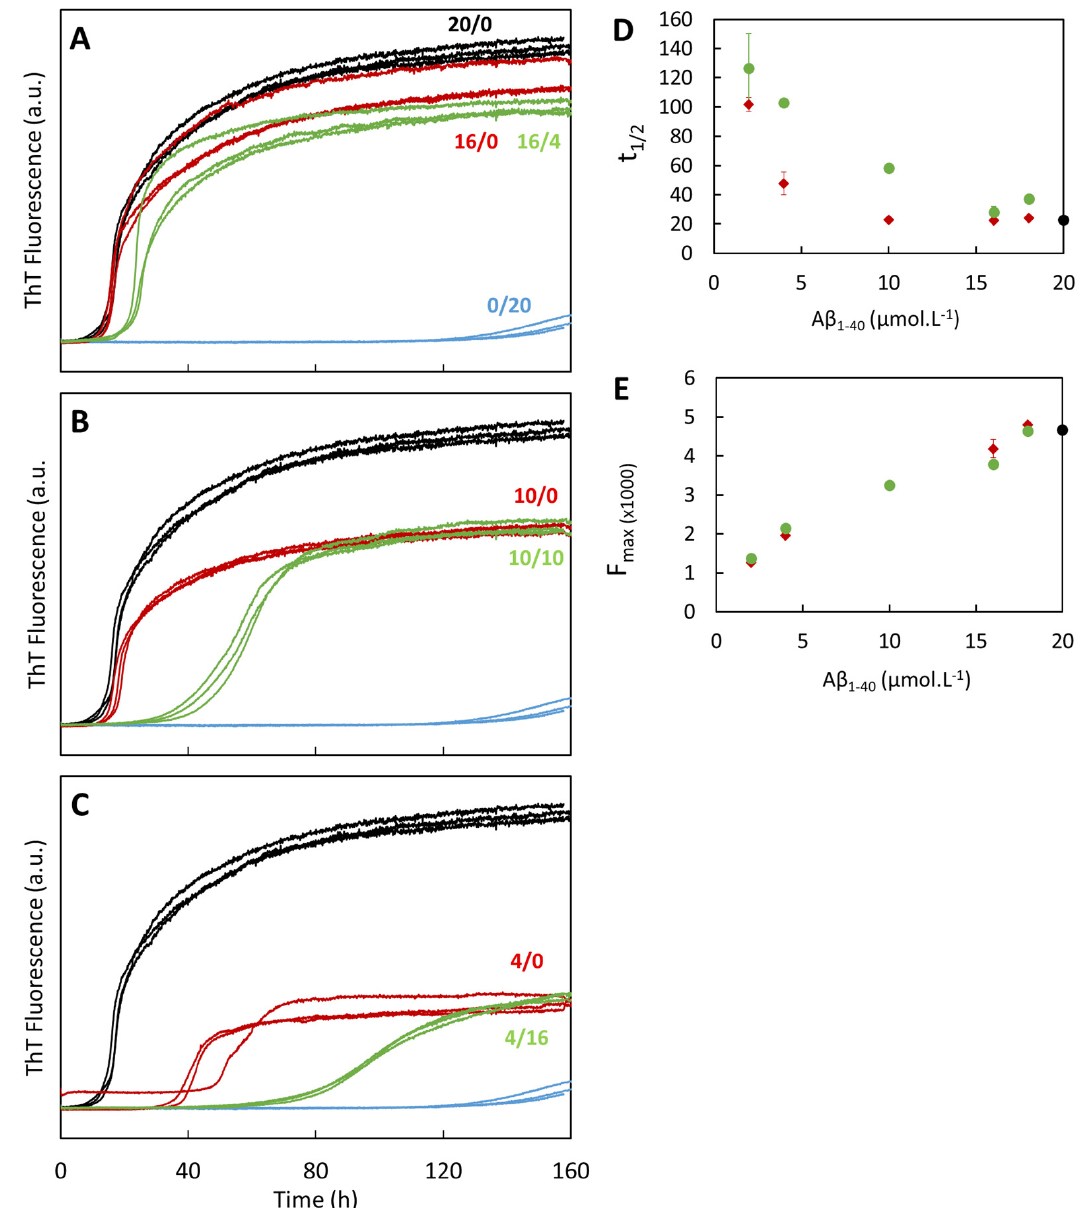
Figure 4. Kinetic monitoring of A β 1–40 and ox A β 1–40 co-assembly using ThT fluorescence as a function of the ratio between peptides (Experiment N°1). Curves are shown as triplicate. [A β 1–40 ]/[ ox A β 1–40 ] = 20/0 µM (black), 0/20 µM (blue), 16/4 µM (green), 16/0 µM (red) ( A ); [A β 1–40 ]/[ ox A β 1–40 ] = 10/10 µM (green), 10/0 µM (red) ( B ); [A β 1–40 ]/[ ox A β 1–40 ] = 4/16 µM (green), 4/0 µM (red) ( C ). Average t 1/2 ( D ) and F max ( E ) values as a function of the A β 1–40 concentration with ox A β 1–40 presence ([A β 1–40 ] + [ ox A β 1– 40 ] = 20 µM) (green dots) or without (red dots). HEPES buffer 50 mM, [NaCl] = 65 mM, pH 7.4. Y-